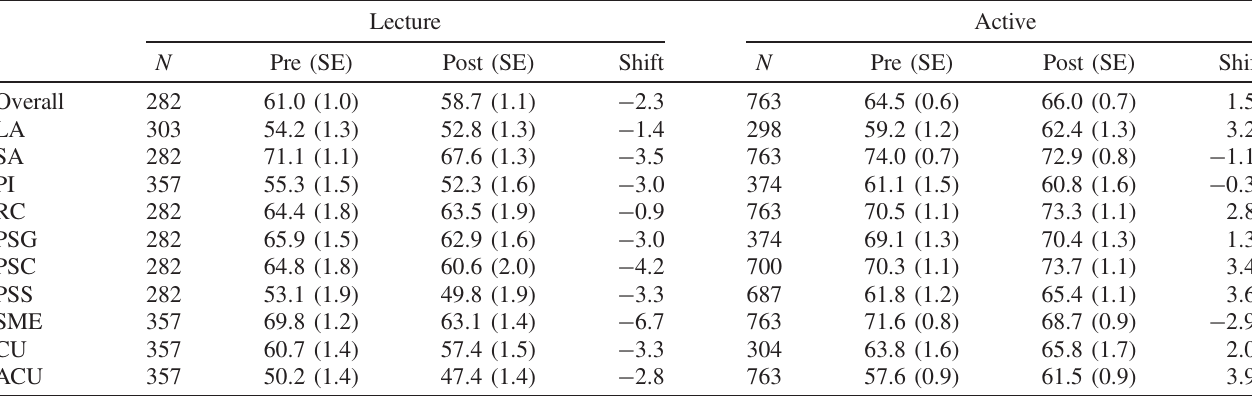
TABLE VI. Detailed descriptive statistics for the Fall-only CLASS. SE indicates Standard error.